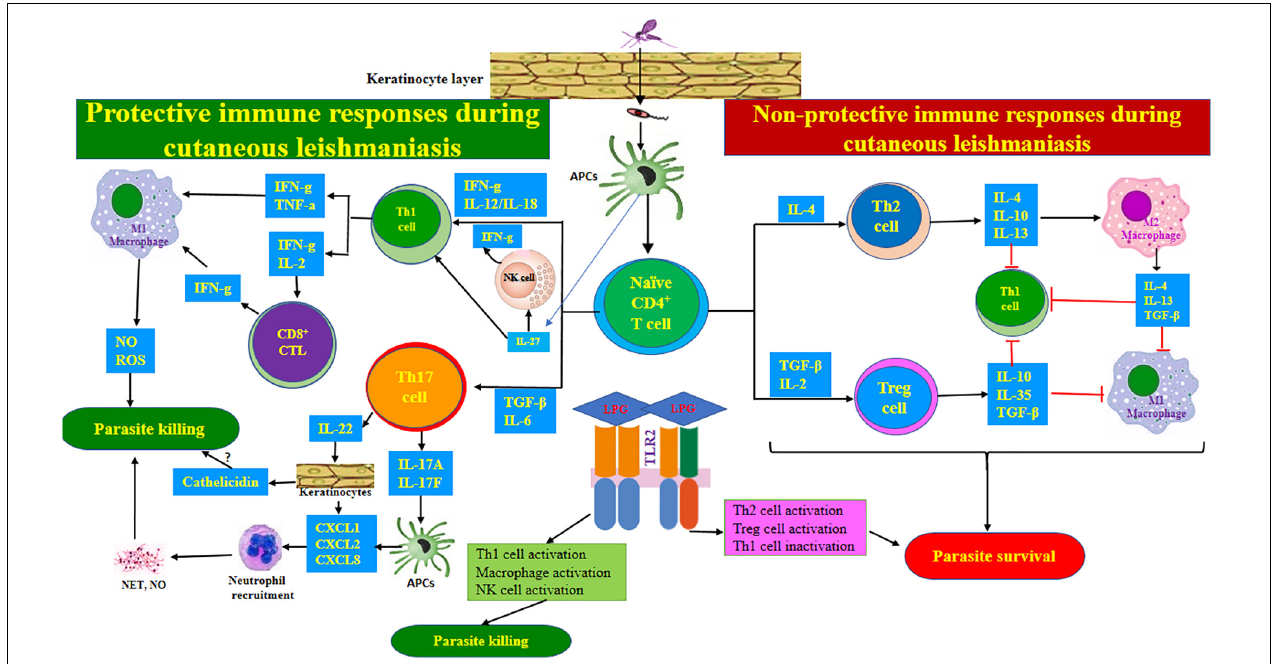
FIGURE 2 | Immune responses during cutaneous leishmaniasis. After injecting the parasite into the skin, the Leishmania -derived antigens are offered to naïve CD4 + T-lymphocytes by macrophages. Then, naïve CD4 + T-lymphocytes are differentiated to the various subsets of effector T cells according to specific local cytokines in the milieu. The Th1 and CTL-related immune responses exert protective impacts, while Th2- and Treg cell-associated responses support parasite survival. Th17 cell-mediated responses may be protective through neutrophil recruitment. IL-27 and IL-23 can contribute to protection via supporting Th1 and Th17 cell responses, respectively. TLR2 recognizes parasite-derived LPG and exhibits functional duality during CL. The anti- L. major impacts of TLR2 can be exerted mainly by activating Th1 cells, macrophages, and NK cells, while pro- L. major impacts may be mediated by inactivating Th1 cells while activating Th2 and Treg cells.